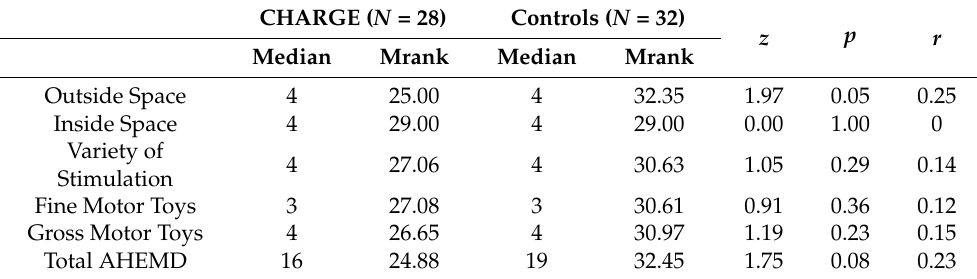
Table 6. Comparison of AHEMD scores between children with and without CHARGE